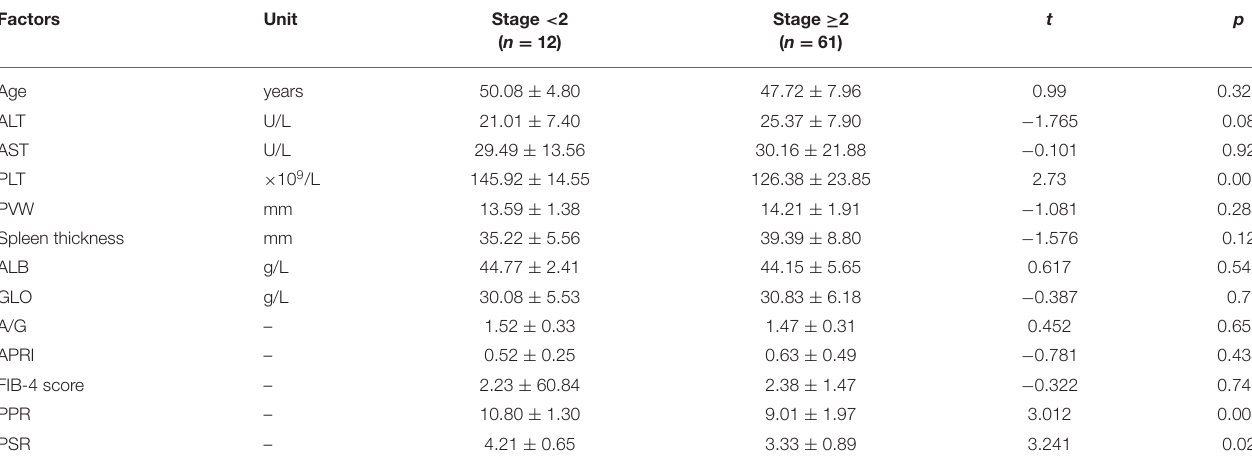
TABLE 3 | Characteristics of liver-fibrosis progression among HBV-infected patients with HBeAg-negativity and a normal ALT level. Factors Unit Stage < 2 ( n = 12)